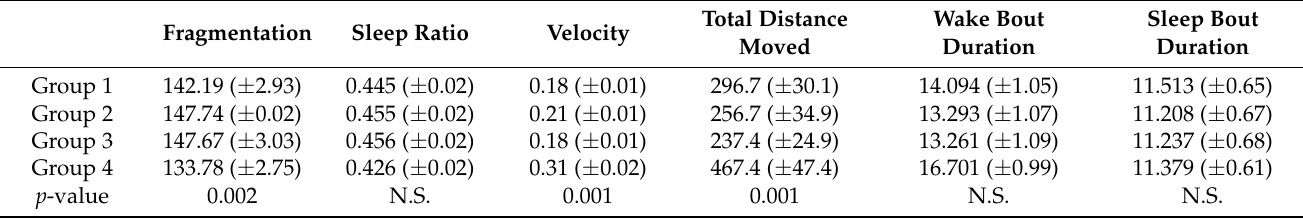
Table 1. Sleep parameters in larval zebrafish. Group 1, control; Group 2, group exposed for 24 h to VPA; Group 3, group exposed for 48 h to VPA; and Group 4, group exposed for 72 h to VPA. The experimental groups were compared to control group and the results are represented as average ± SEM; p < 0.05 was considered to be significant, MANOVA and Bonferroni analysis; N.S., not significant results.